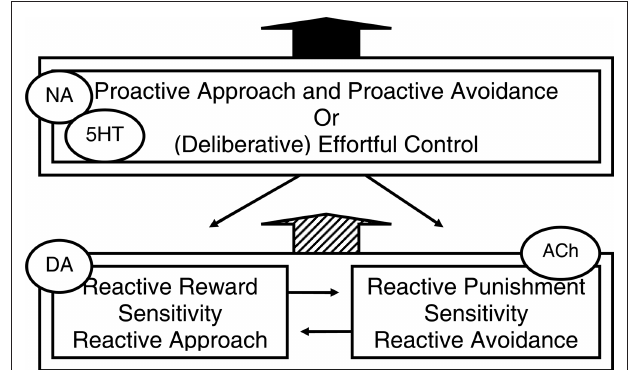
Figure 2 | Three temperamental influences (and associated neuromodulators) on behavior that reflect different behavioral programs. A reactive system for approaching rewards and a reactive system for avoiding threats or punishment both interact, collaborate and compete with, and are dampened by a proactive system guided by context models or effortful control. This figure is inspired by Figure 1 in Carver et al. (2008, 2009) who in turn noted inspiration by Rothbart and others. NA, noradrenalin; DA, dopamine; ACh, acetylcholine; 5HT,